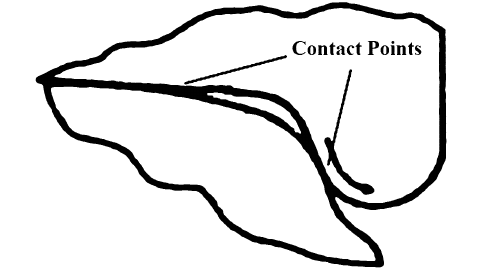
Fig. 4 Schematic of two contact points [24]